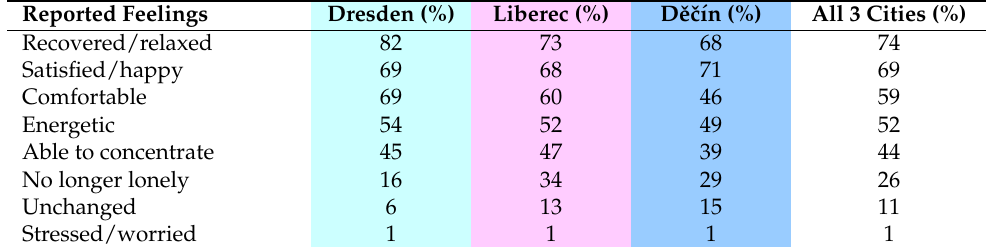
Table 2. Feelings while visiting urban green space (total agreement).